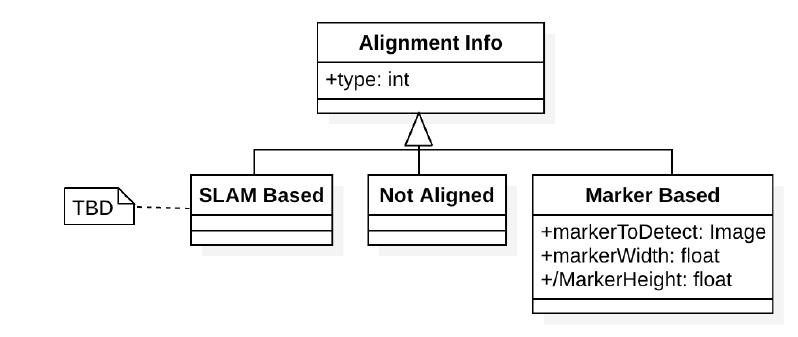
Figure 8. Detail on the Alignment Method associated with a